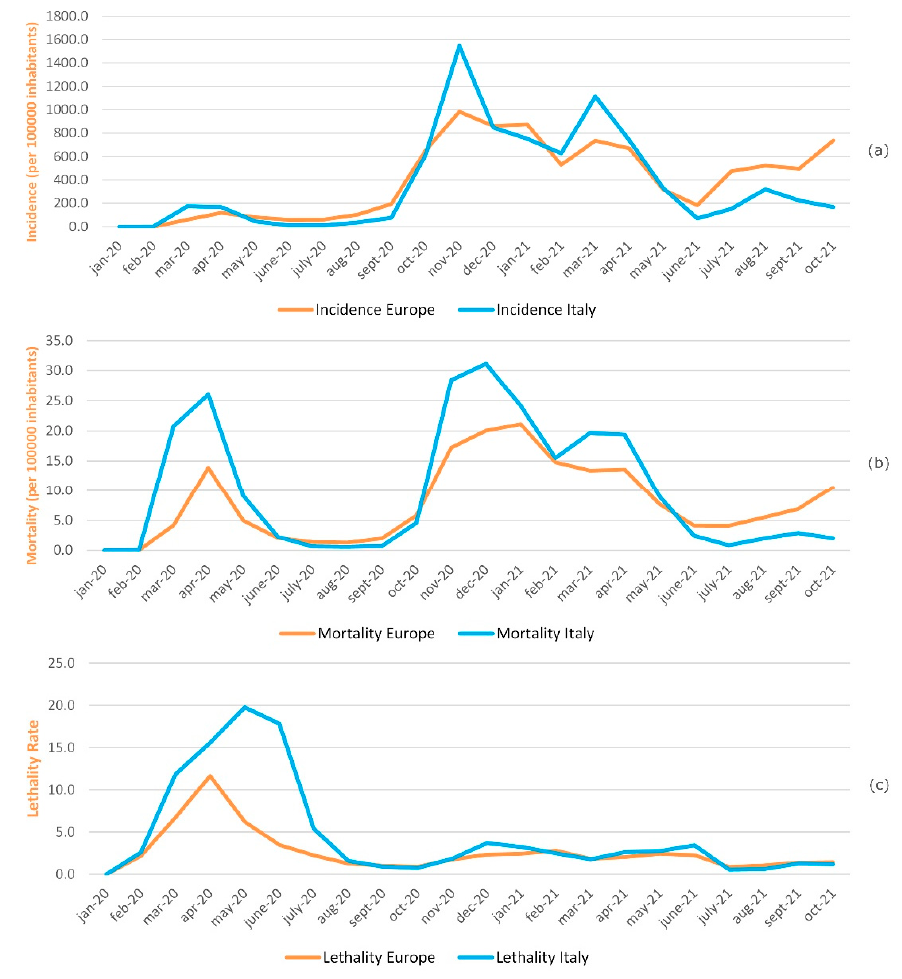
Figure 4. Comparison between Europe and Italy: ( a ) Incidence, ( b ) mortality, ( c ) lethality. For European countries, the resident population reported by the Our World in Data was used. For Italy, the